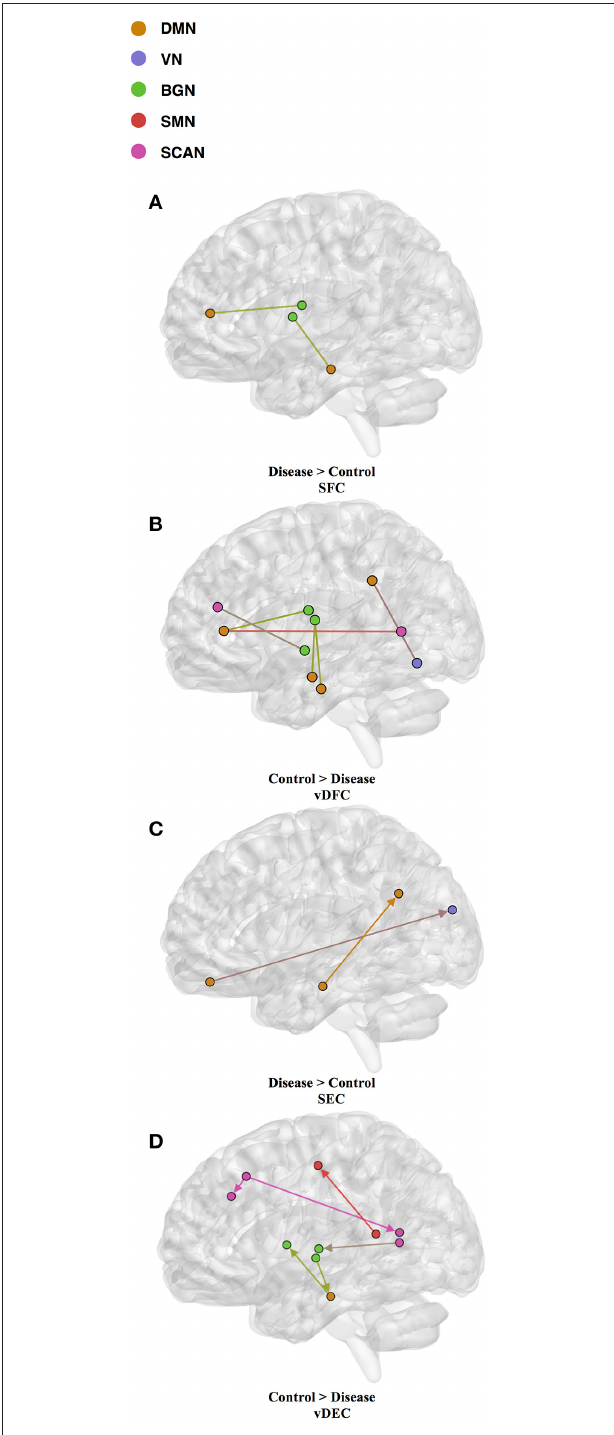
FIGURE 9 | (A) SFC; (B) vDFC; (C) SEC; (D) vDEC features. selected by GA and hierarchical (PTSD/PCS). Selected features were split into two groups, i.e., (1) control > disease (PTSD and PTSD/PCS) and (2) disease > control. DMN, Default mode network; VN, Visual network; BGN, Basal ganglia network; SMN, Sensory motor network; SCAN, Semantic cognition and attention